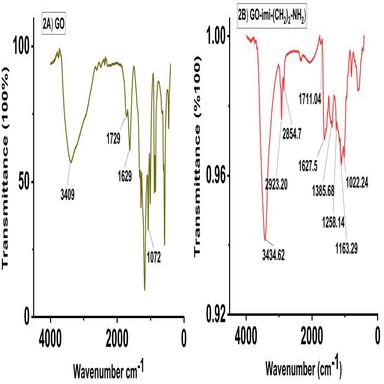
The FT-IR spectra for pure graphene oxide and functionalized graphene oxide GO-imi-(CH2)2-NH2.